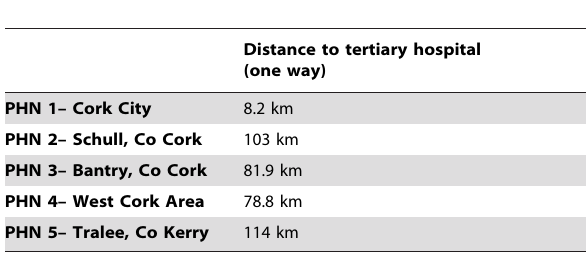
Table 2. Public Health Nurse (PHN) areas of practice within Ireland and distance from tertiary referral